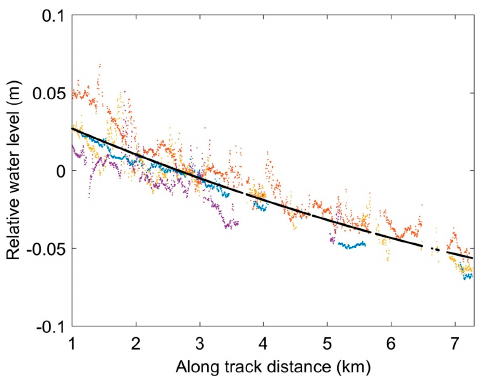
Figure 19. Radargram related to 12 September (upper plot) and waveforms corresponding to the strongest echo (lower plot) for IE (black), incoherent burst (cyan) and coherent burst (green).